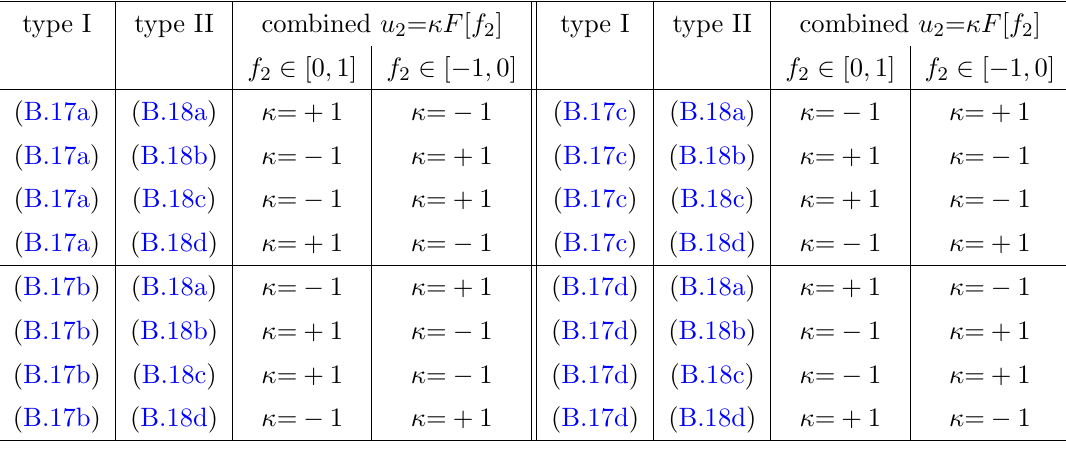
Table 2. The combination of the two one-parameter triangular solutions (B.17) and (B.18) is consistent for a few choices, resulting in one-parameter families of exact solutions. Here p F [ f 2 ] = 1 (cid:0) f 2 . 2